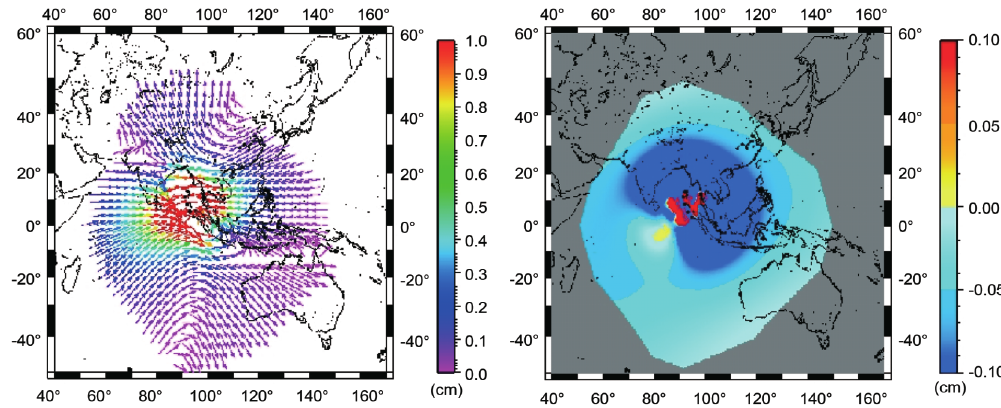
Fig. 24. Ground horizontal (vector plot on the right ) and vertical (color plot on the left ) displacement field cal- culated for the 2004 Sumatra earthquake with a plane source (2D) approximation.